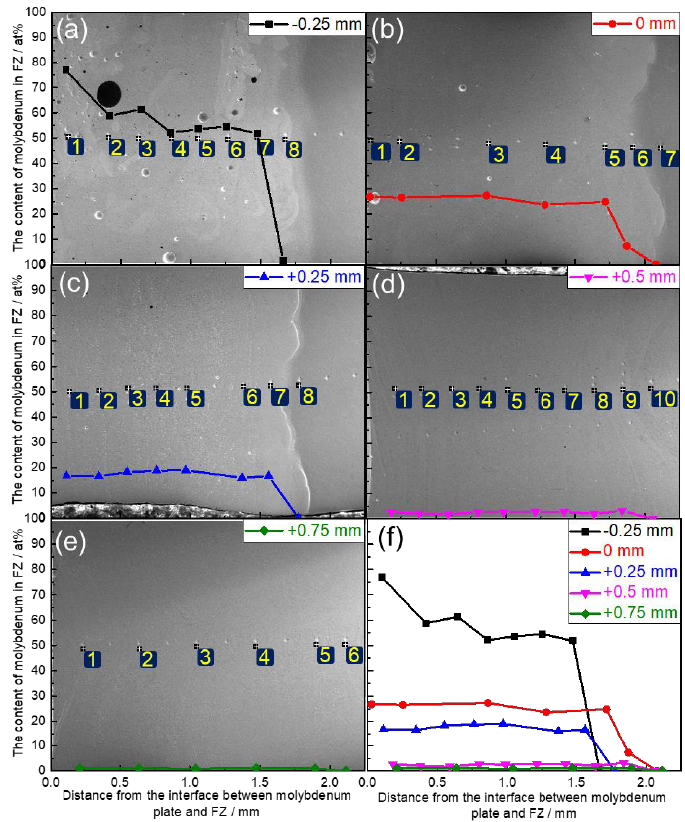
Figure 9. EDX results of the content of molybdenum in Mo/Ti joints obtained at various laser beam offsets (the numbers (1–10) in the blue boxes in this figure represent the positions of point composition analysis). ( a ) point composition analysis result of welded joint −0.25 mm; ( b ) point composition analysis result of welded joint 0 mm; ( c ) point composition analysis result of welded joint +0.25 mm; ( d ) point composition analysis result of welded joint +0.5 mm; ( e ) point composition analysis result of welded joint +0.75 mm; ( f ) the comparison of point composition analysis results of five welded joints .